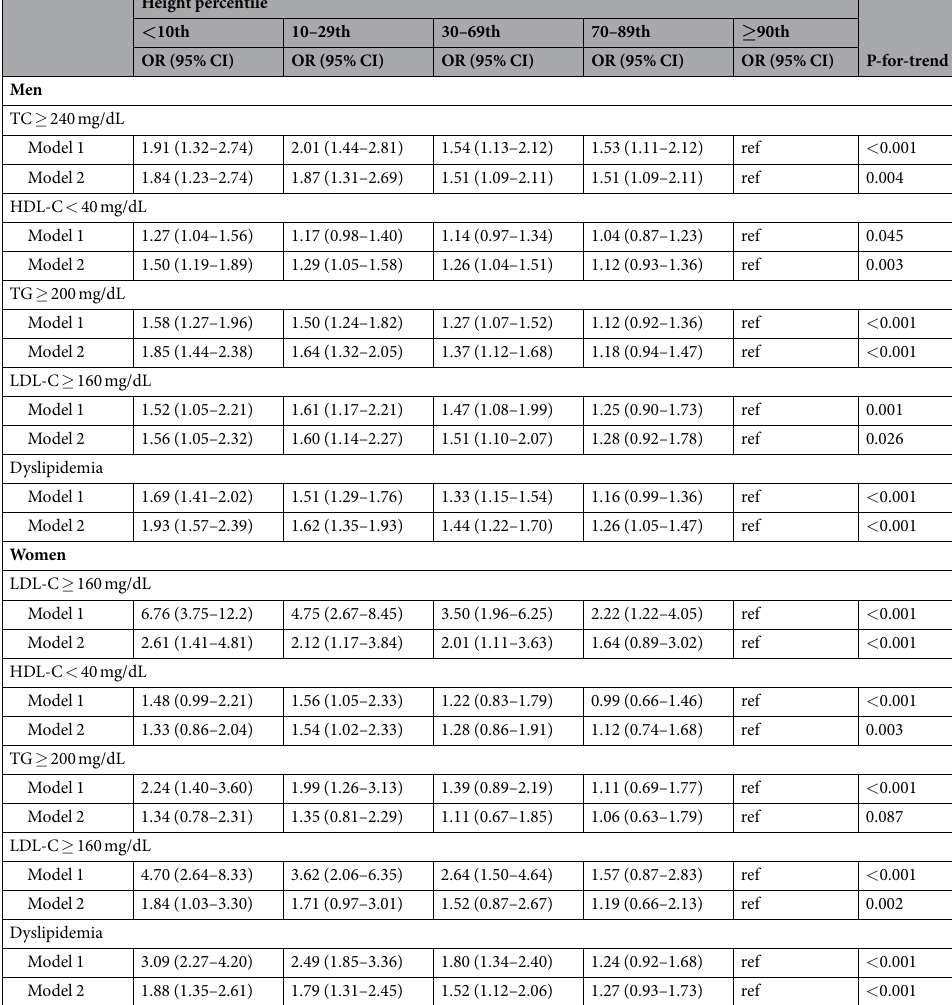
Table 4. Adjusted odds ratios (95% confidence interval) for dyslipidemia in adults according to the height percentile. Model 1: Unadjusted. Model 2: Adjusted for age, waist circumference, systolic/diastolic blood pressure, fasting glucose levels, household income, physical activity, alcohol consumption, and menopause status (for women). CI, confidence interval; HDL-C, high density lipoprotein-cholesterol; LDL-C, low density lipoprotein-cholesterol; OR, odd ratio; TC, total cholesterol; TG,